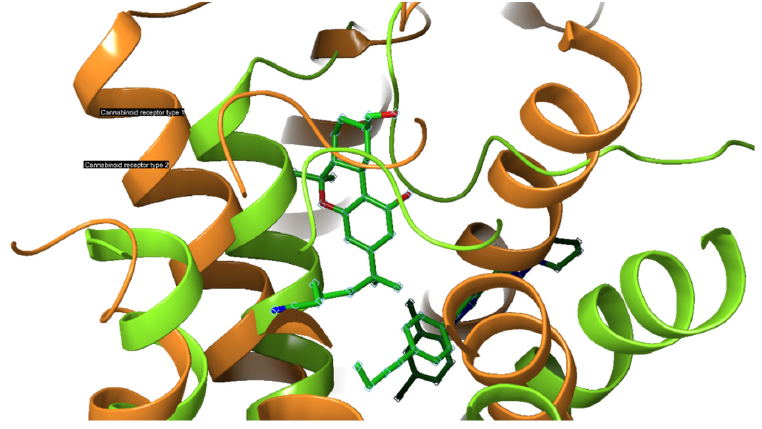
Figure 3. Comparison of the binding pocket of CB1-R and CB2-R. Modified using Schrödinger Re-